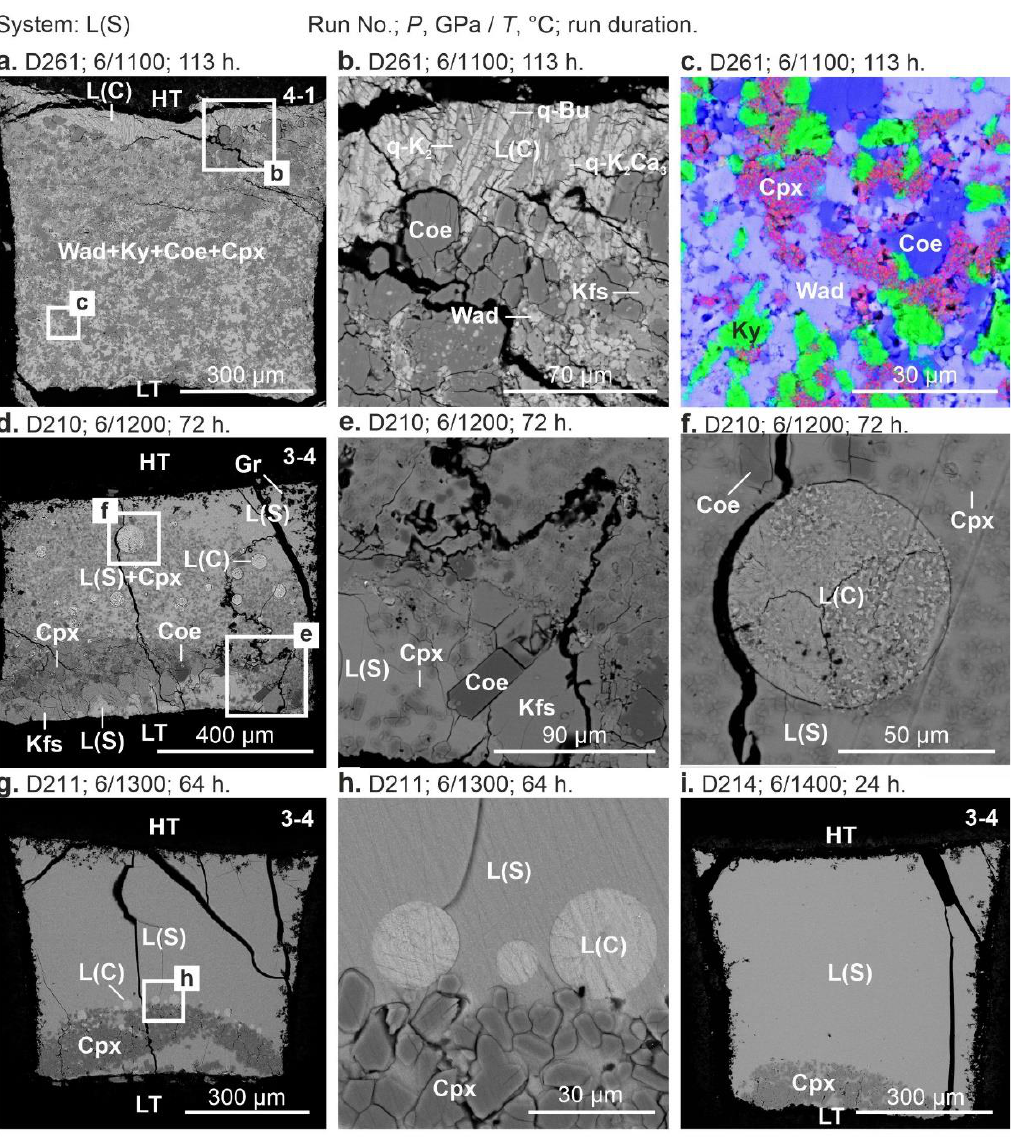
Figure 8. BSE of sample cross-sections in the system L(S) at 6 GPa: ( a – c ) 1100 °C (run D261, 113 h); ( d – f ) 1200 °C (run D210, 72 h); 1300 °C (run D211, 64 h); ( g – h ) 1300 °C (D211, 64 h); ( i ) 1400 °C (D214, 25 h). The color image ( c ) was taken in element mapping mode. See the Figure 1 caption for other details.